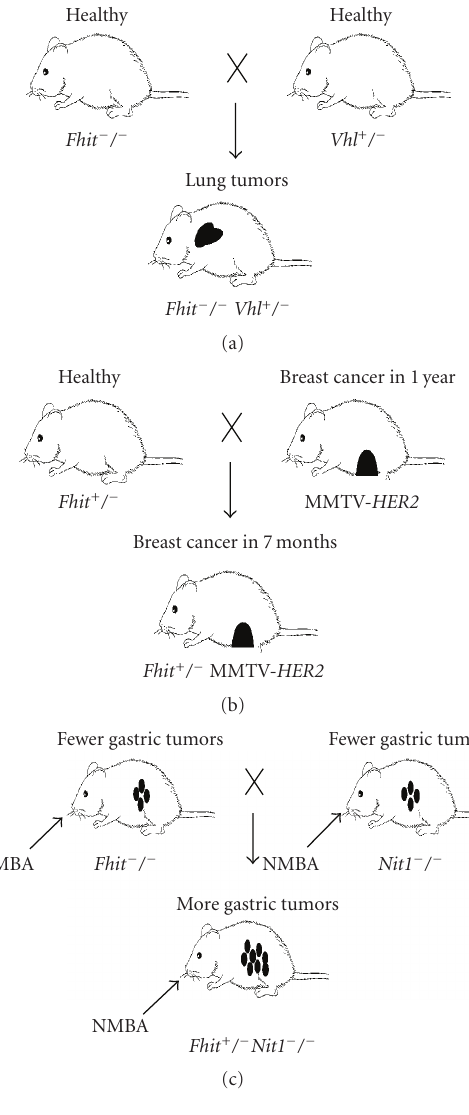
Figure 1: Cooperating e ff ect of FHIT with Vhl (a), HER2 (b), and Nit1 (c) in mouse